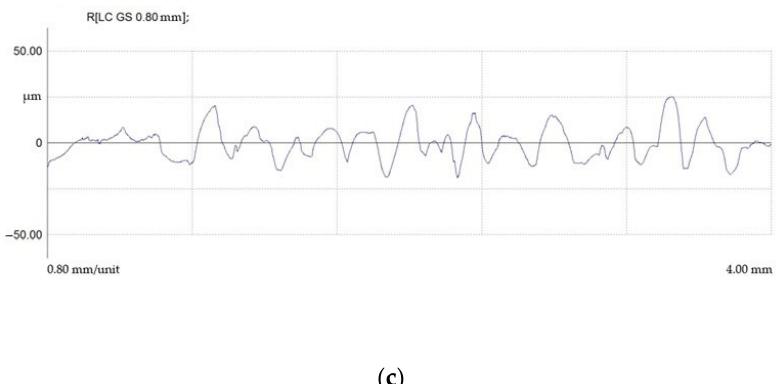
Figure 17. Profilograms of the surface of steel 15 after EDM in rough mode using ETs from: ( a ) copper; ( b ) graphite; ( c ) composite.